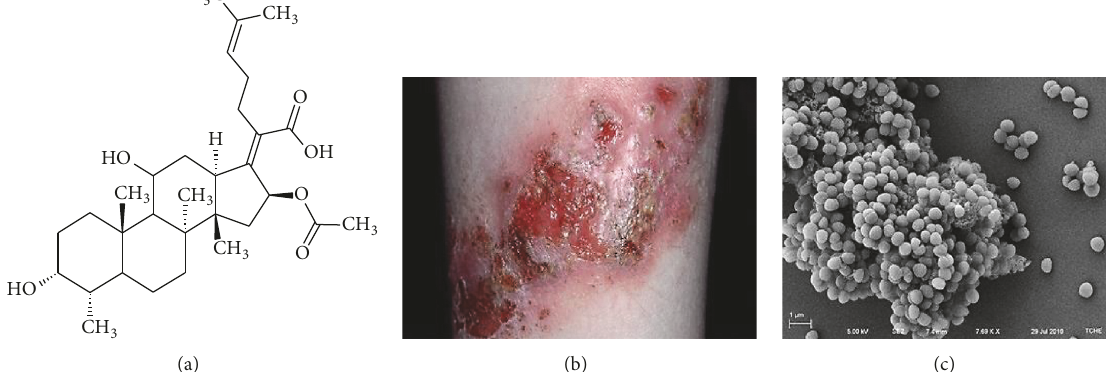
Figure 1: (a) Chemical structure of fusidic acid, (b) an example of infected atopic eczema of the forearm, and (c) a scanning electron micrograph of Staphylococcus aureus